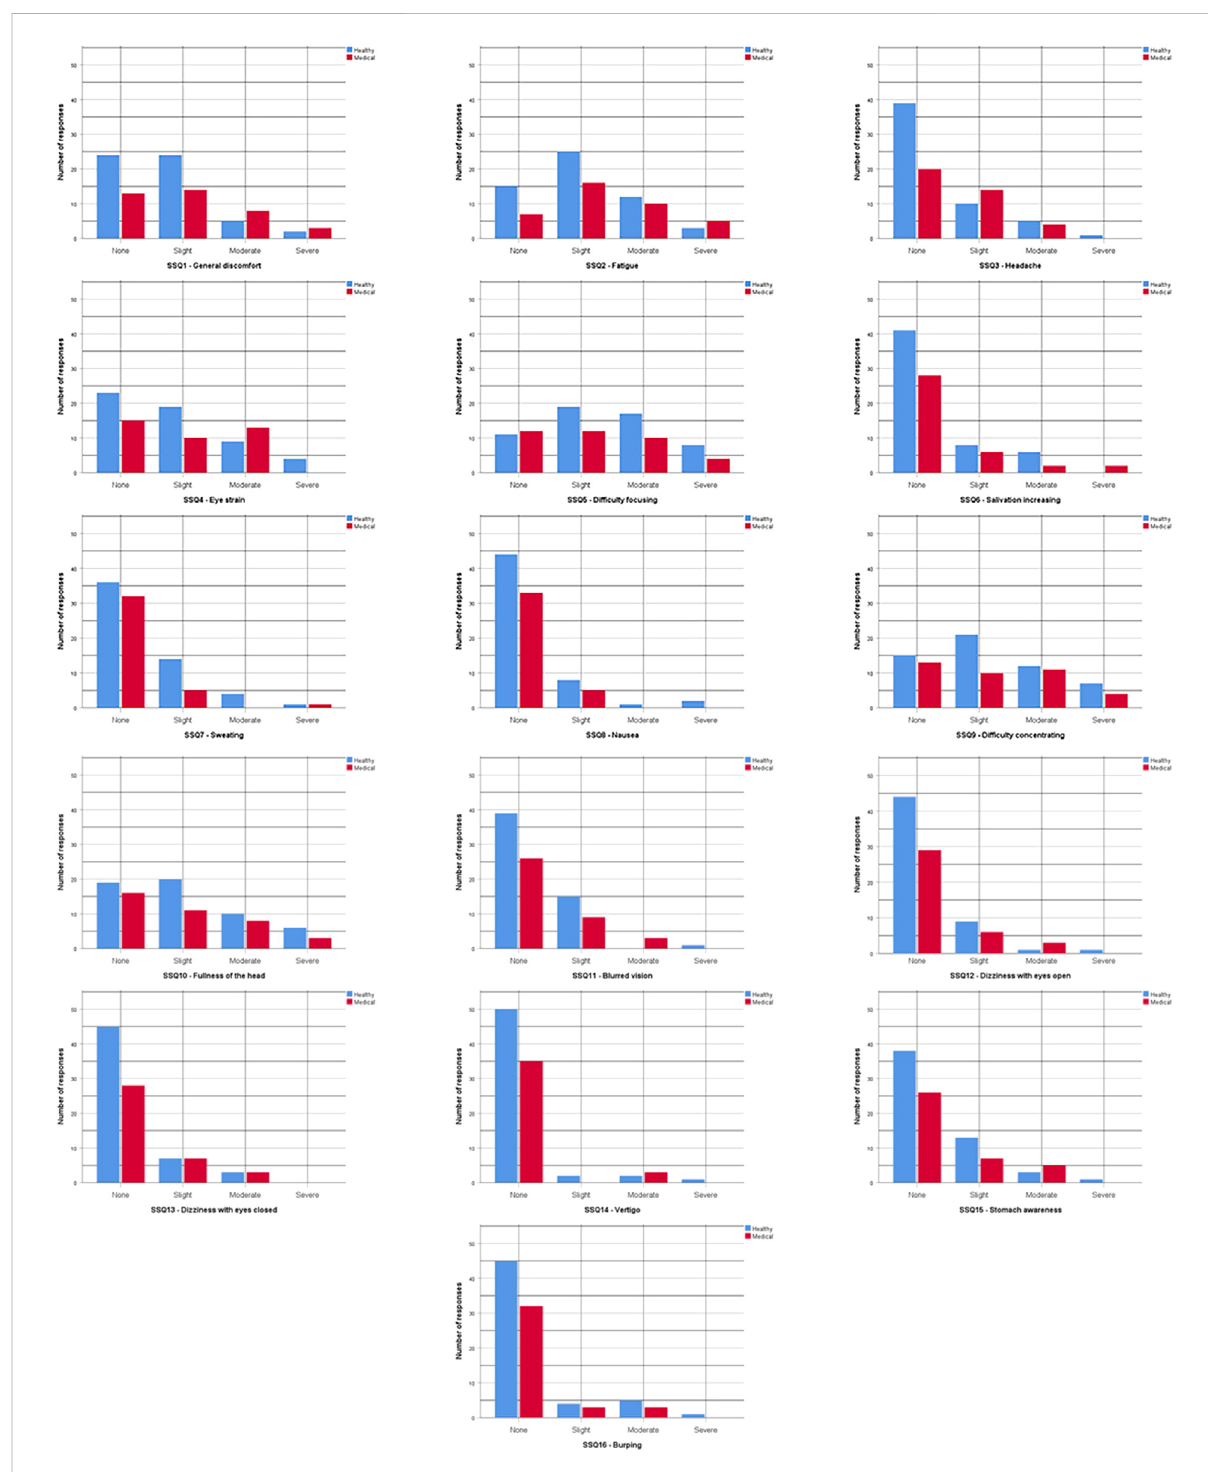
FIGURE 4 Left — right, top — bottom. SSQ questions 1 – 16 score